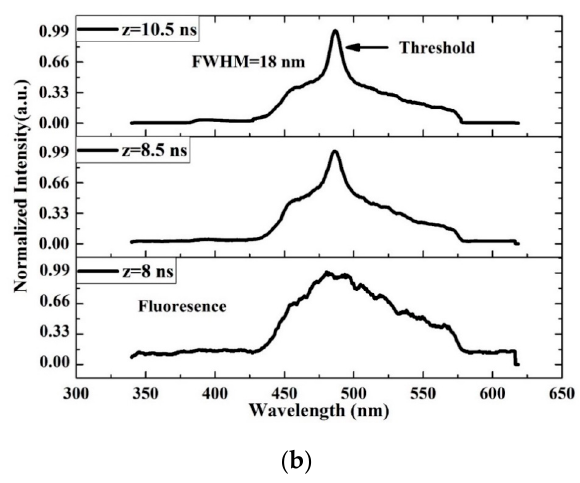
Figure 13. Time dynamics of the CO thin film ( a ) threshold ( b ) time profile of threshold in chloroform at pump energy of 0.65 mJ and a concentration of 15 mg/mL.